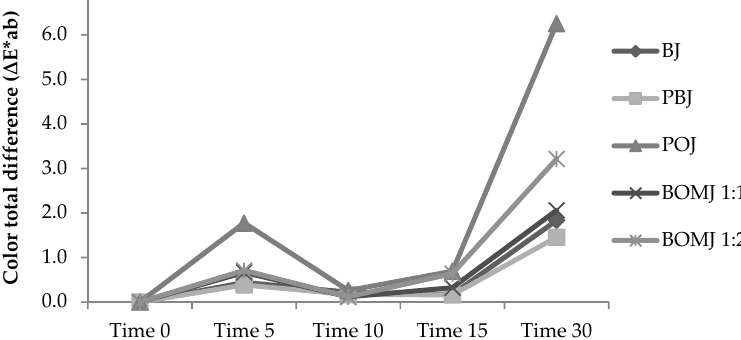
Figure 1. Total color difference ( ∆ E *ab) in juices stored at 4 °C for 30 days. BJ, raw beet juice; PBJ,